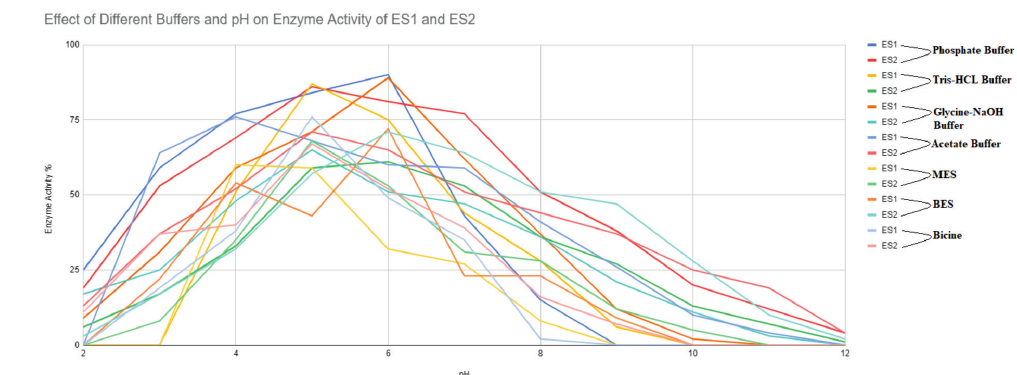
Fig. 2. Effect of different buffers and pH on enzyme activity of ES1 and